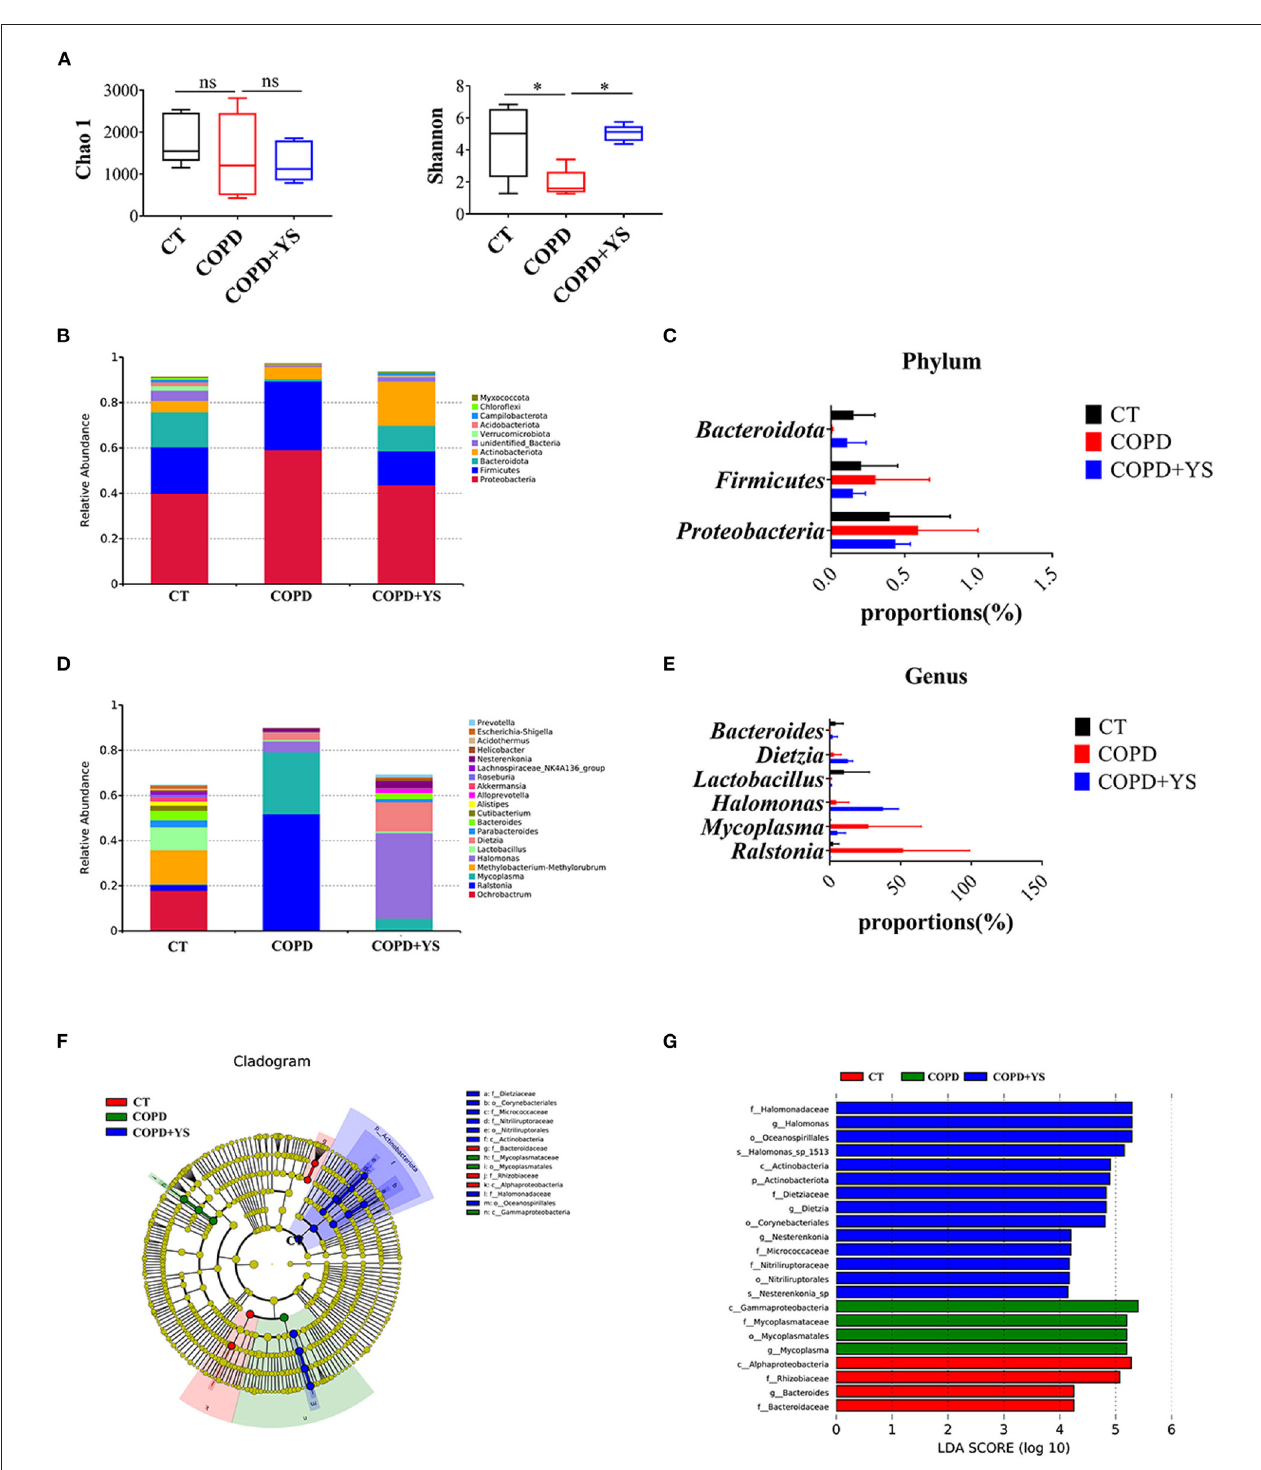
FIGURE 7 | (A) Analysis of alpha diversity: Chao1 and Shannon index ( n = 5). (B) The relative abundance of top ten pulmonary microbiota in the phylum ( n = 5). (C) The advantage of pulmonary microbiota in the phylum ( n = 5). (D) The relative abundance of the top twenty pulmonary microbiota in the genera ( n = 5). (E) The advantage of pulmonary microbiota in the genera ( n = 5). (F) Taxonomic differences of pulmonary microbiota among different groups. The taxonomic cladogram was obtained by LEfSe. Differences are represented by the color of the most abundant class. The diameter of each circle is proportional to the taxon’s abundance ( n = 5). (G) Linear discriminant analysis score of each group of gut microbiota ( n = 5). The data are presented as the means ± SEM of three experiments (ns, non-significant, * P < 0.05). The analysis of pulmonary microbiota was performed using the online tool-NovoMagic at https://magic.novogene.com via a personal account.